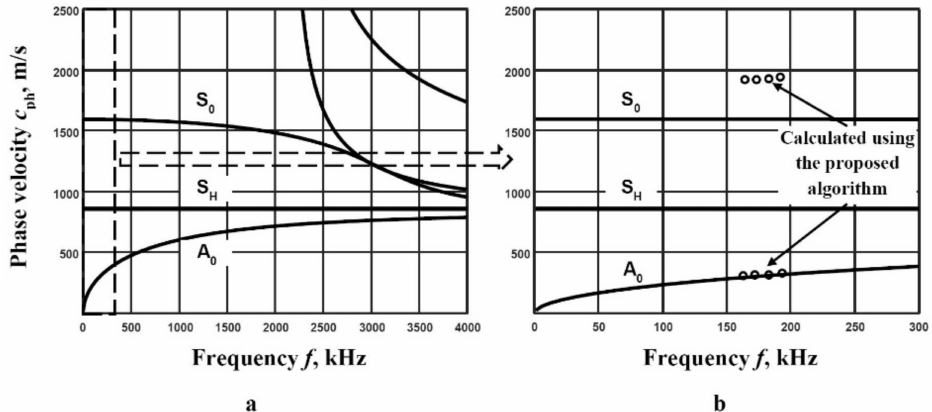
Figure 7. Phase velocity dispersion curves of Lamb wave modes calculated by the SAFE method in d = 200 µ m thickness PVC film ( a ) and the reconstructed segments of the phase velocity dispersion curves of the A 0 and S 0 modes, using the proposed method (dots) and the SAFE calculations ( b ).